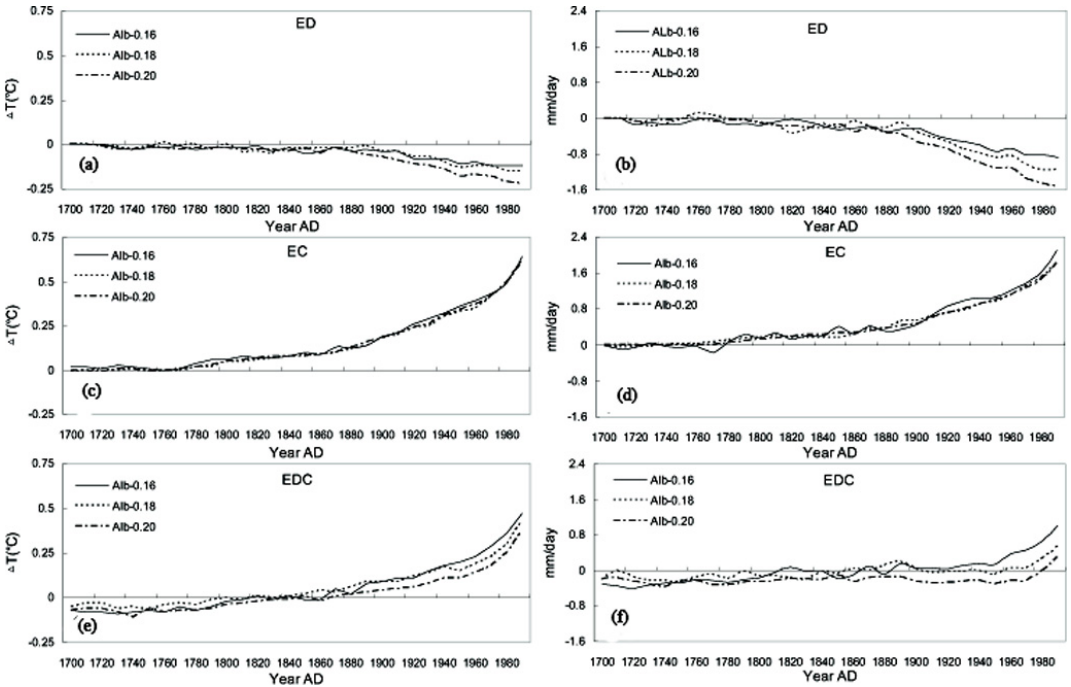
Fig. 7. Simulated climatic changes in the ED (a) , (b) , EC (c) , (d) and EDC (e) , (f) simulations. (a) , (c) and (e) Changes in annual mean temperature for NH ( ◦ ); (b) , (d) and (f) changes in annual mean integrated precipitation over 45–75 ◦ N (mmday − 1